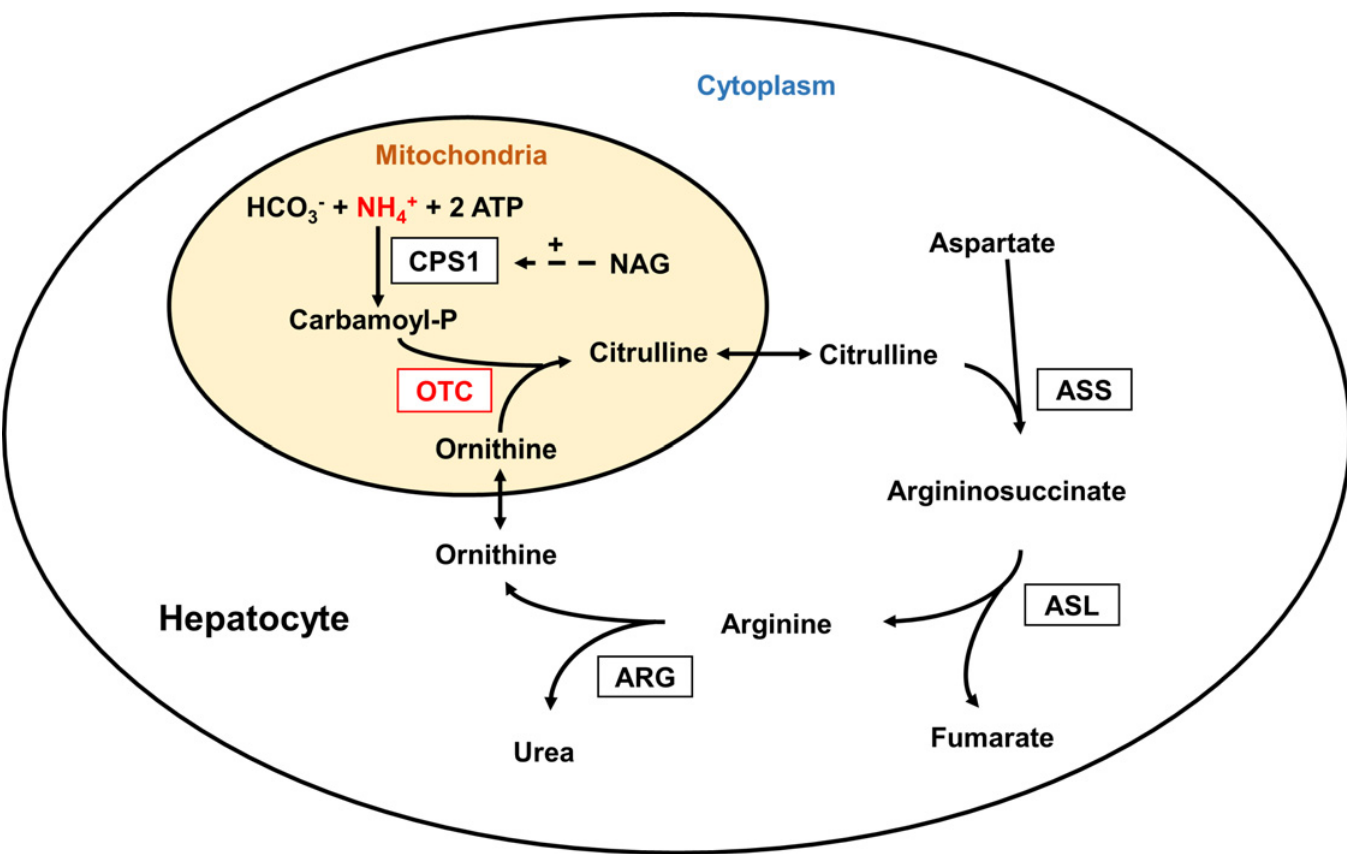
Fig 1. Urea cycle. In the urea cycle the “ toxin ” ammonium (NH 4+ ) is converted to non-toxic urea by five consecutive enzymatic reactions in the liver. In hepatocytes, the rate-limiting, ATP-dependent enzyme carbamoyl phosphate synthetase 1 (CPS1), which is allosterically activated by N-acetyl glutamate (NAG), produced by N-acetyl glutamate synthase (NAGS), not shown, and ornithine transcarbamylase (OTC) are located in the mitochondria, while argininosuccinate synthetase (ASS), argininosuccinate lyase (ASL) and arginase (ARG) are in the cytoplasm. Inherited defects in any of these enzymes can cause recurrent episodes of hyperammonemia. Defects in two mitochondrial transporters, not shown, may also result in